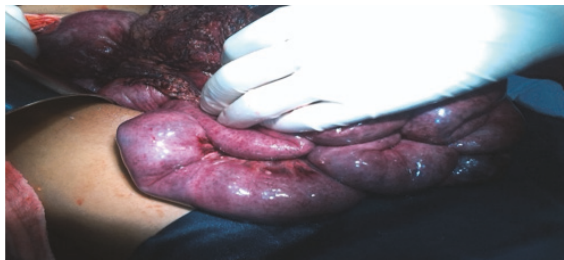
Figure 2: Gross specimen showing patchy ischemia of small intes- tine,peritoneum,andomentumfrompatienthavinggastrointestinal and peritoneal ischemic